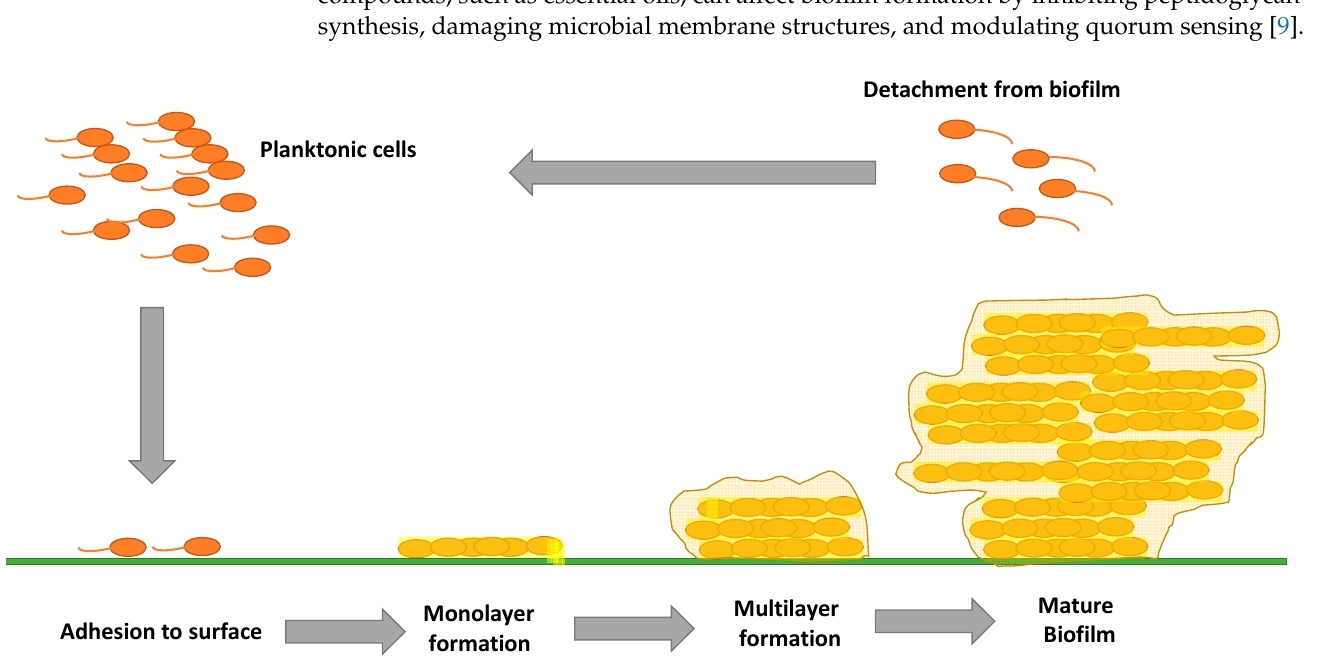
Figure 1. Sequence of stages of bacterial biofilm formation.